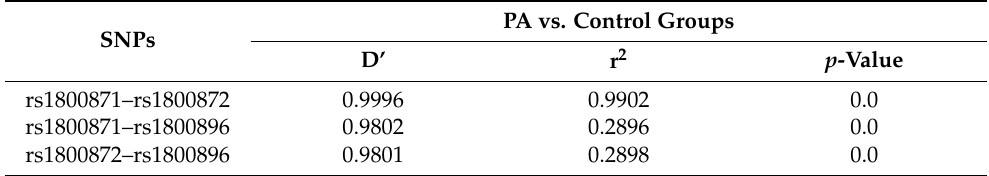
Table 5. Linkage disequilibrium between every two IL-10 SNPs. PA vs. Control Groups SNPs D’ r 2 p